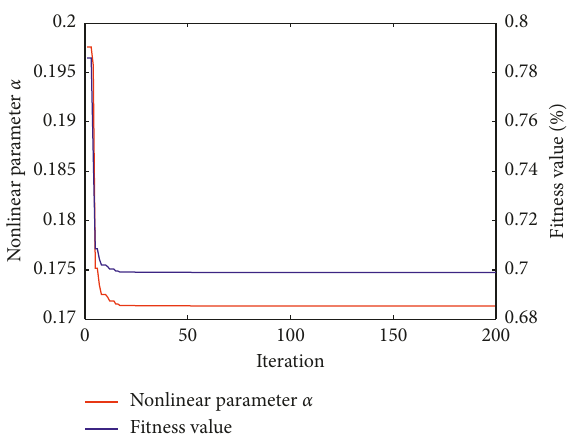
Figure 6: Convergence curve of WOA in Case